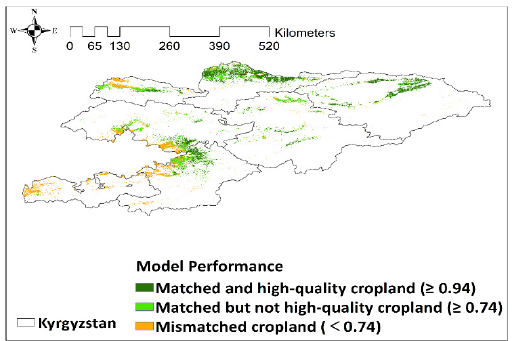
Figure 4. Model performance of the random forest model by comparing predicted cropland and existing cropland. existing